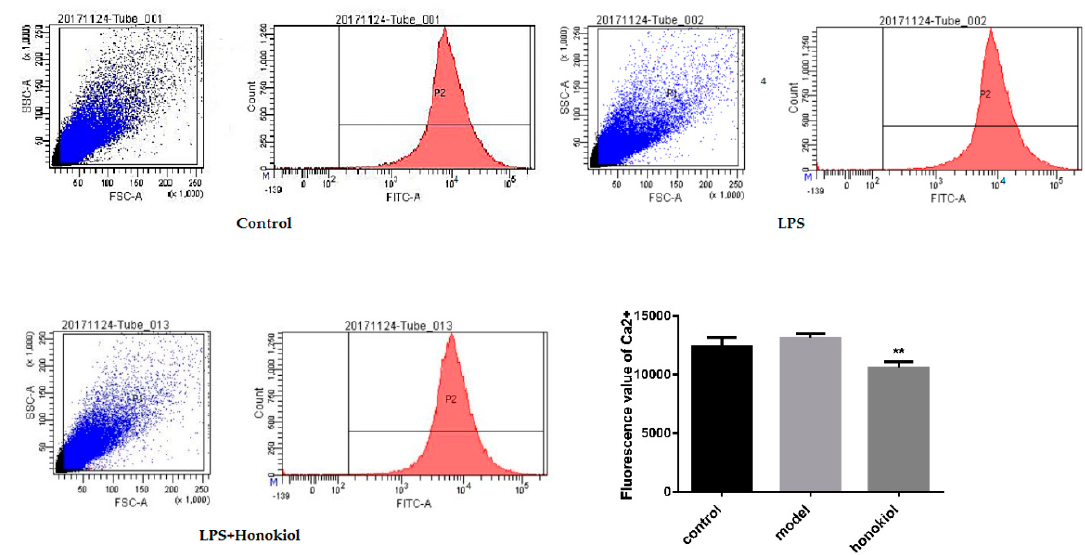
Figure 6. The e ff ect of honokiol on free Ca 2 + levels in the brain cells of mice. Data are expressed as Figure 6. The effect of honokiol on free Ca 2+ levels in the brain cells of mice. Data are expressed as mean ± SEM ( n = 4). ** p < 0.01 LPS + Honokiol vs. mean ± SEM ( n = 4). ** p < 0.01 LPS + Honokiol vs LPS.